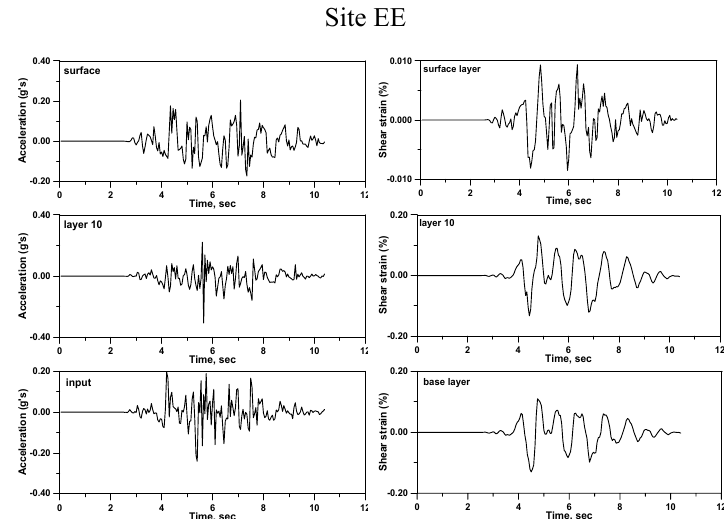
Fig. 19. Acceleration (left column) and strain (right column) time histories at different ground level.